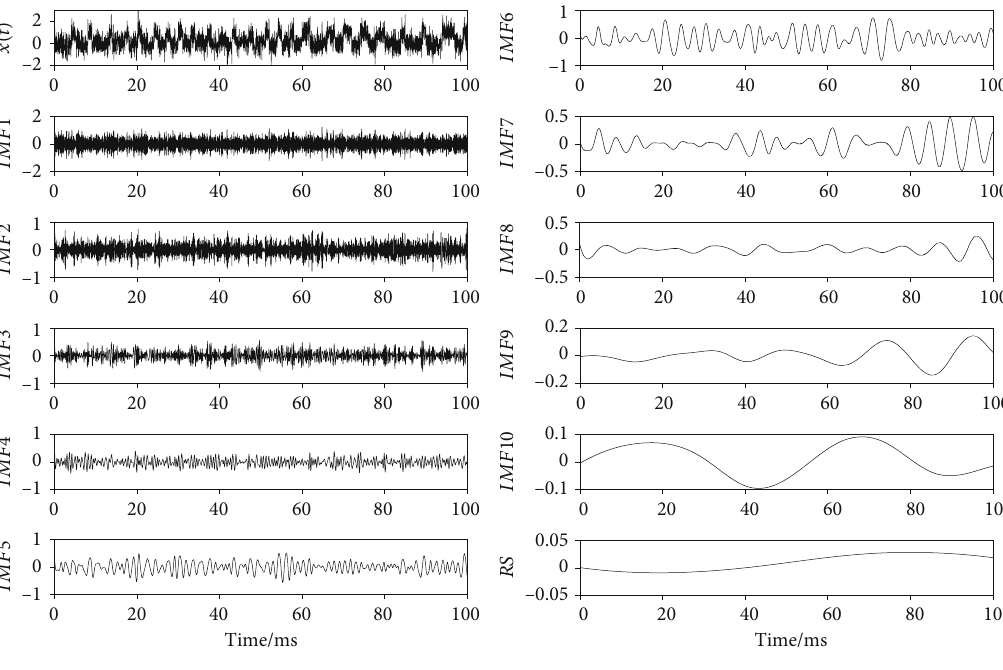
Figure 10: Noise signal decomposition.